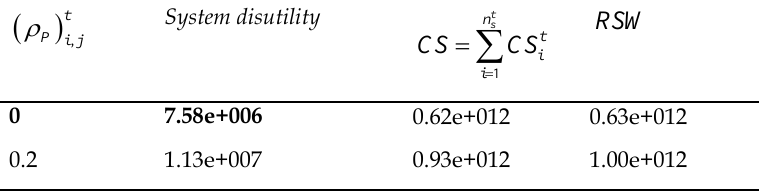
Table 2. Comparisons of system disutility, consumer surplus and social welfare